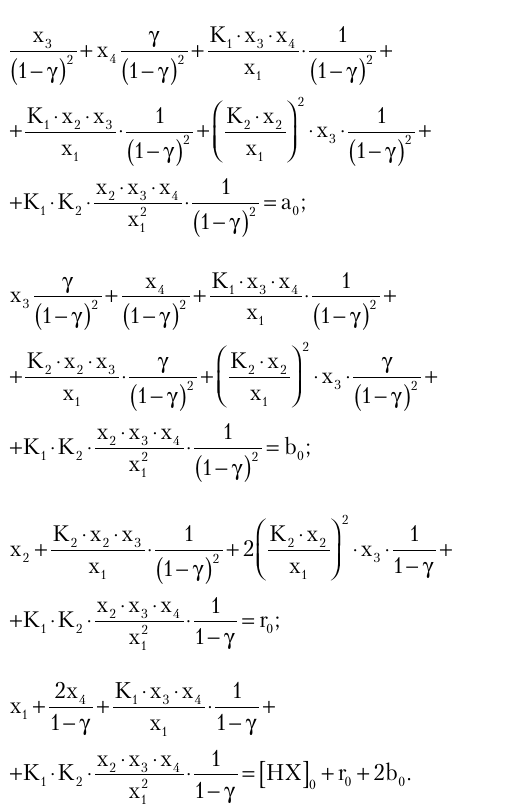
Based on the presence of polymers with and from 1 to ∞ in the system, a system of 4 material balance equations (in frag- ments A, B, R, X) is obtained containing sums of an infinite number of members. Due to the presence of a connection be- tween the components in the form of a geometric progression (3), which, according to the content of the problem, must be conver- gent, infinite sums are folded and a closed system of equations of